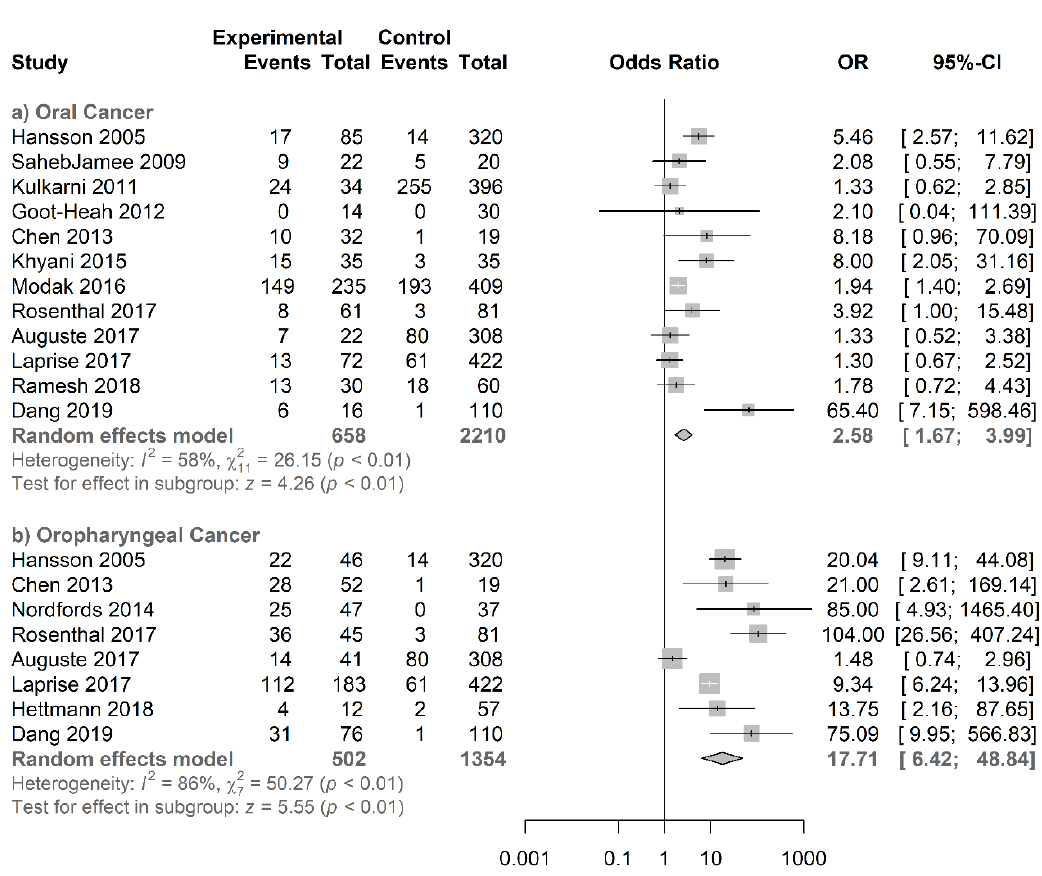
Figure 6. Forest plot for the studies on the association between salivary HPV and anatomic tumor subsites. The squares indicate the ORs in each study, with square sizes inversely proportional to the standard error of the OR. The diamond shape indicates the pooled ORs. Horizontal lines represent 95% CIs. I2 > 50% indicates severe heterogeneity. ( a ) Oral Cancer and ( b ) Oropharyngeal Cancer.